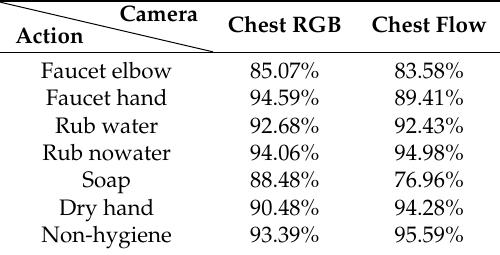
Table 3. Classifier accuracy for the chest camera with spatial and temporal models; seven